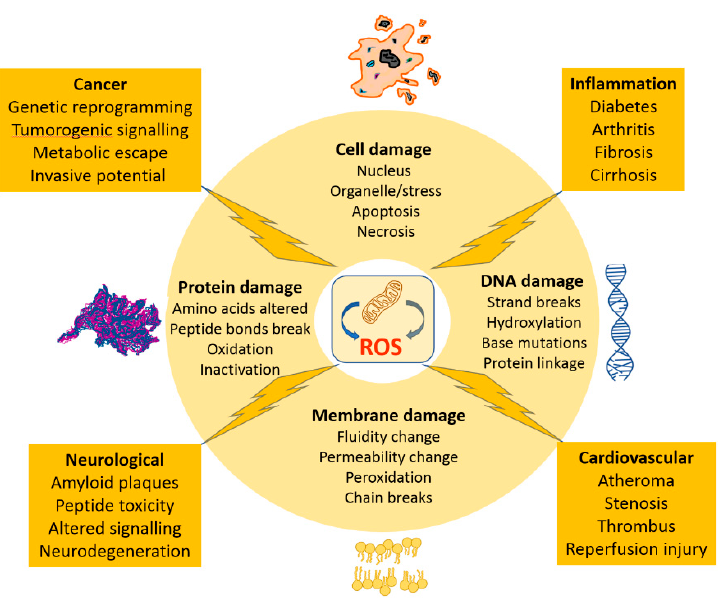
Figure 5. Schematic of the tissue outcomes of excess mitochondrial generated ROS, describing the generic molecular damage accruing to lipid membranes, proteins, DNA and ultimately the single cell. The subsequent whole tissue outcomes are provided for selected tissue types and with respect to inflammatory disease and